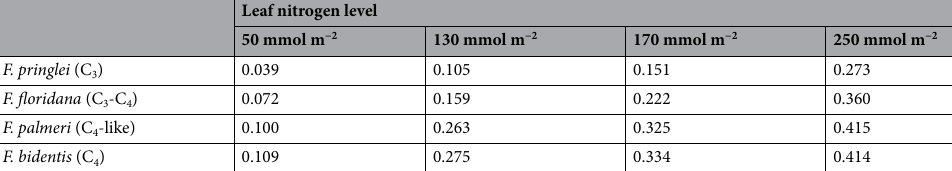
Table 2. Required nitrogen re-allocation ( δ n , [fraction]) for different leaf nitrogen levels for various Flaveria species. The required nitrogen re-allocation represents the total fraction of nitrogen that needs to be re-allocated between photosynthetic pools to optimally adjust photosynthesis from the evolutionary scenario to a given experimental growth